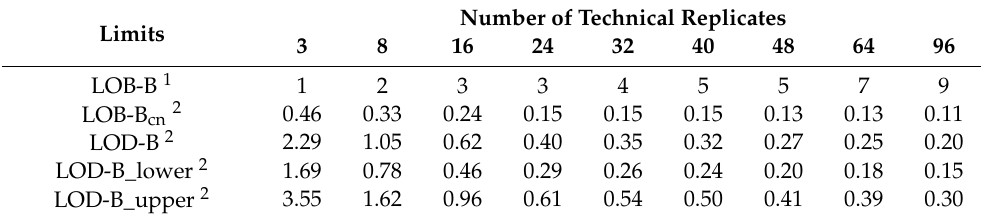
Table 4. The limit of blank with background (LOB-B, LOB-B cn ) (number of hits, and copies per reaction), and limit of detection with background (LOD-B) (copies per reaction) for given numbers of technical replicates for the coho salmon assay eONKI4 as performance measures. The LOB-B and LOD-B were determined from the background coho salmon eDNA signal in the Goldstream Hatchery experimental tanks. The lower/upper confidence limits for LOD-B are shown. 1 Binomial scale, 2 Copy number